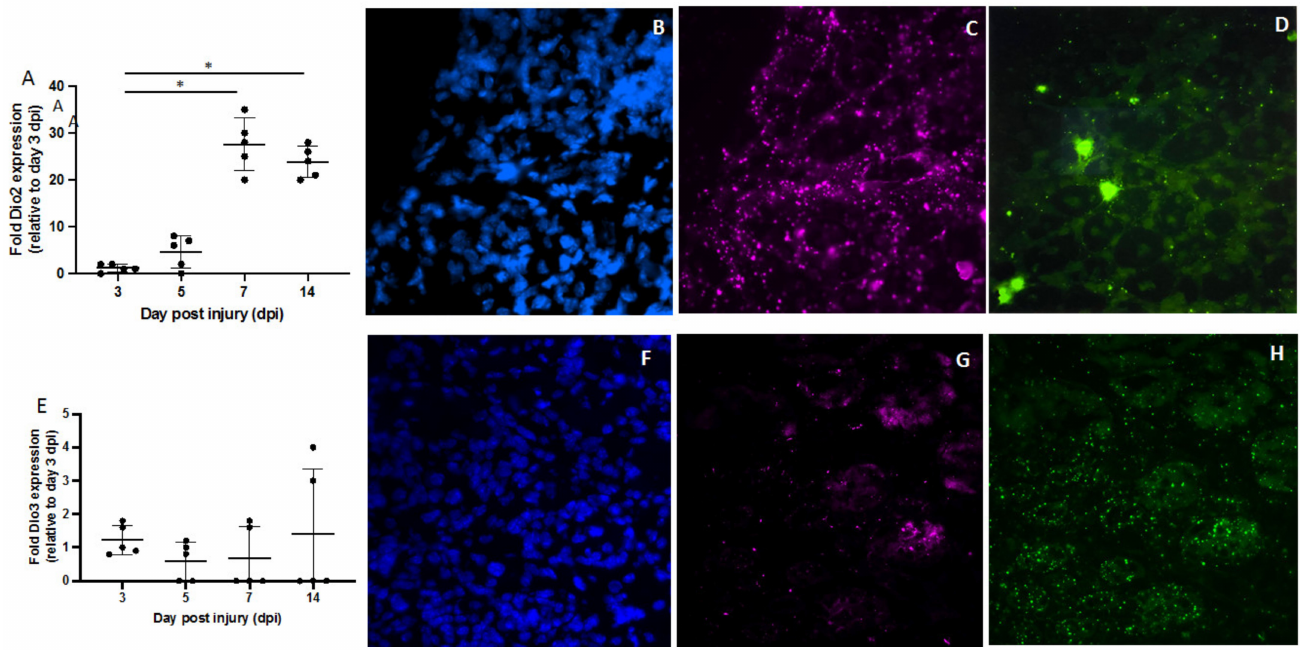
Figure 4. Expression of Dio2 and Dio3 in PDGFA-positive cells. ( A ) Higher expression of Dio2 occurred later in muscle recovery, from day 7 to day 14 (RT PCR, * p = 0.0001). ( B ) DAPI in blue, ( C ) PDGFA-positive cells in pink ( D ) Dio2 expression in green on day 7 after injury. ( E ) RT-PCR showing that the highest Dio3 expression occurred on day 14. ( F ) DAPI in blue, ( G ) PDGFA-positive cells in pink on day 14 and ( H ) Dio3 in the same cells in green. Data are expressed as the mean ± SEM of at least three independent experiments. Images are representative of injury on day 7 for Dio2 and day 14 for Dio3 in one of five different mice analyzed ( n = 5). Scale bar = 50 µ